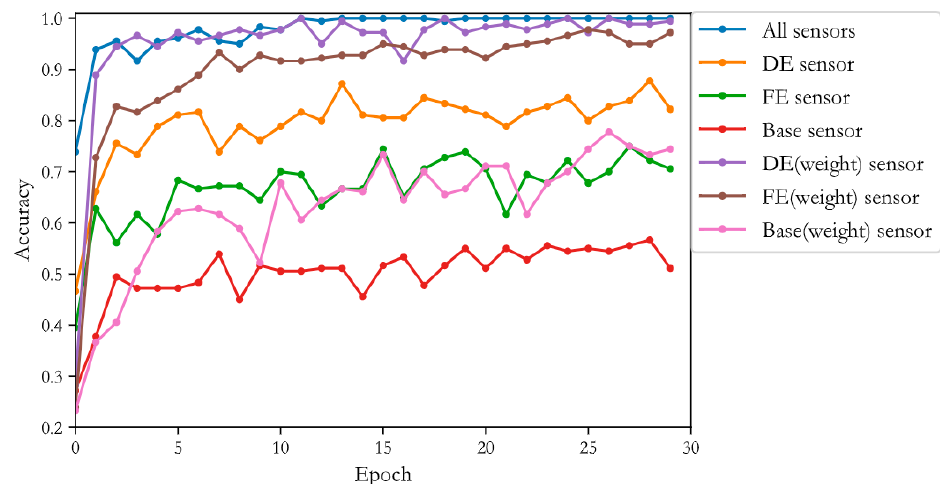
Figure 9. Comparison of recognition accuracy between the different types input.